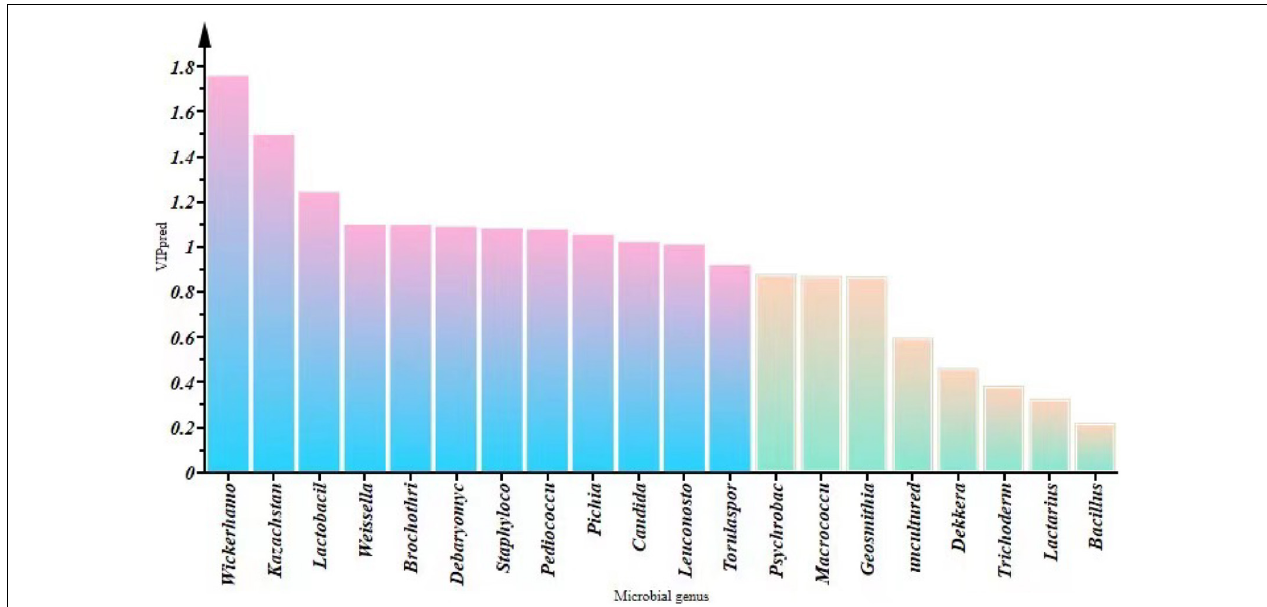
FIGURE 7 | Changes in VIP (pred) values of the top 10 fungi and bacteria by relative abundance at the genus level.